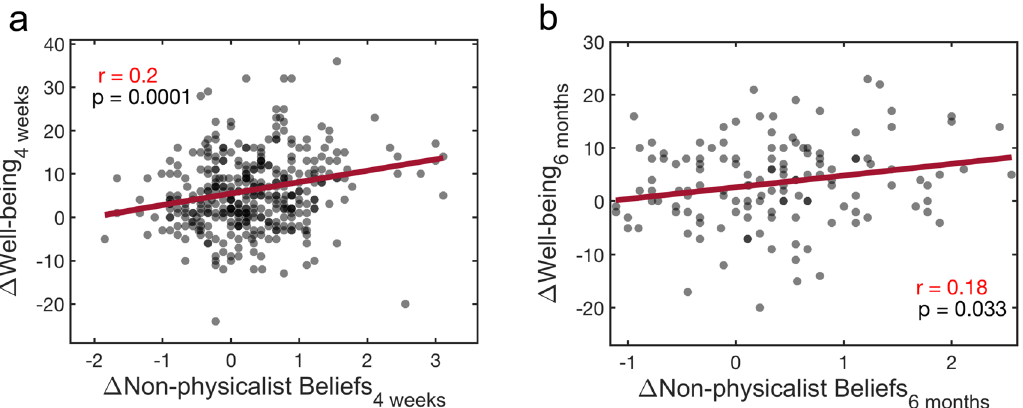
Figure 3. Shifts away from hard materialistic beliefs are associated with increases in well-being. A positive correlation was observed for shifts away from hard materialism versus changes in well-being at both ( a ) 4 weeks and ( b ) 6 months.